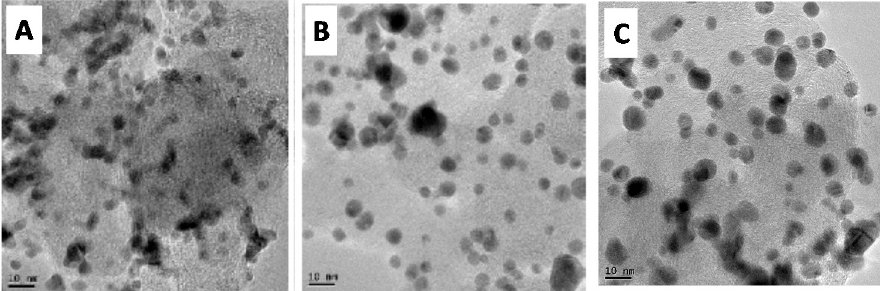
Figure 1. TEM images of ( A ) Pd/C, ( B ) Au/C and ( C ) Pd 3 Au 7 /C materials prepared from the “water in oil” microemulsion method.